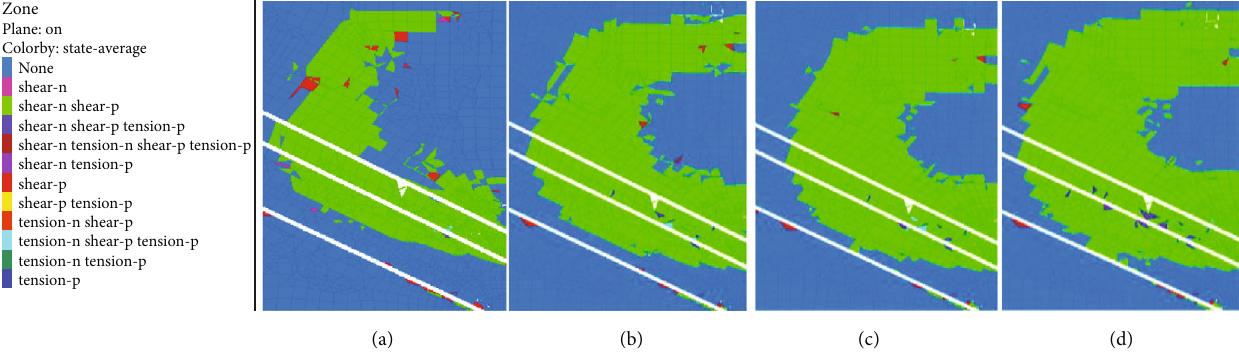
Figure 15: The change of plastic zone in two sides of roadway in 302 mining area when the cutting position is 300m ahead of schedule. (a) Working face advancing 40m; (b) working face advancing 80 m; (c) working face advancing 120m; (d) working face advancing 160 m.